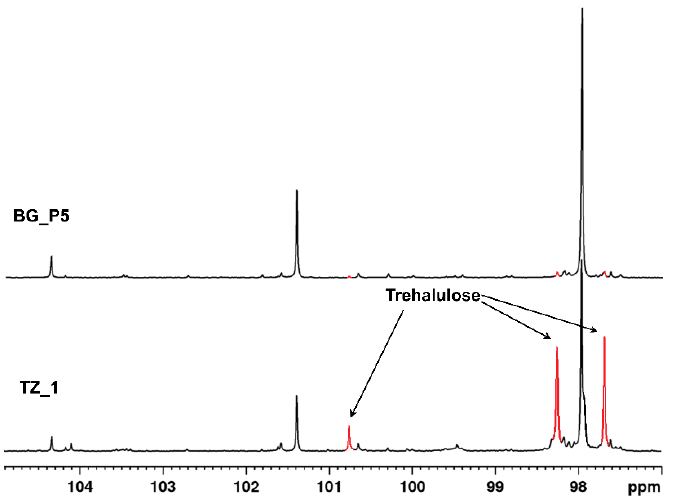
Figure 4. Anomeric 13 C NMR signals in the region 96–105 ppm of M. ferruginea honey (TZ_1) and A. mellifera honey (BG_P5) with anomeric signals of trehalulose indicated.